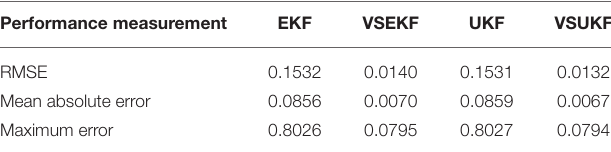
TABLE 2 | Performance comparison. Performance